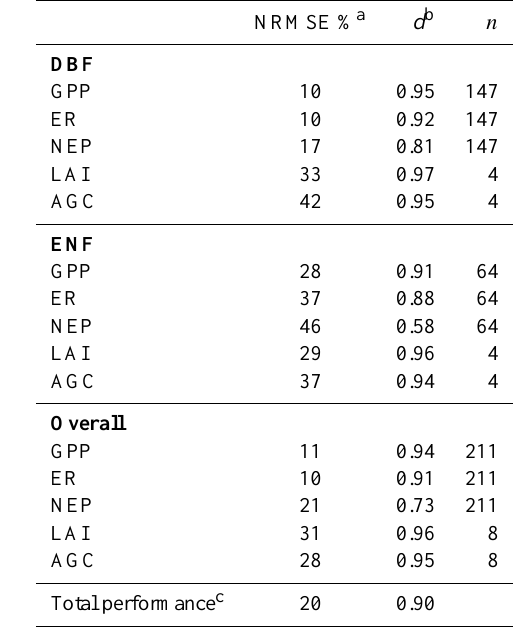
Table 2. PnET-CN model performance in monthly carbon fluxes (GPP: gross primary productivity; ER: ecosystem respiration; NEP: net ecosystem productivity), leaf area index (LAI), and above- ground carbon stock (AGC) for the two chronosequences.